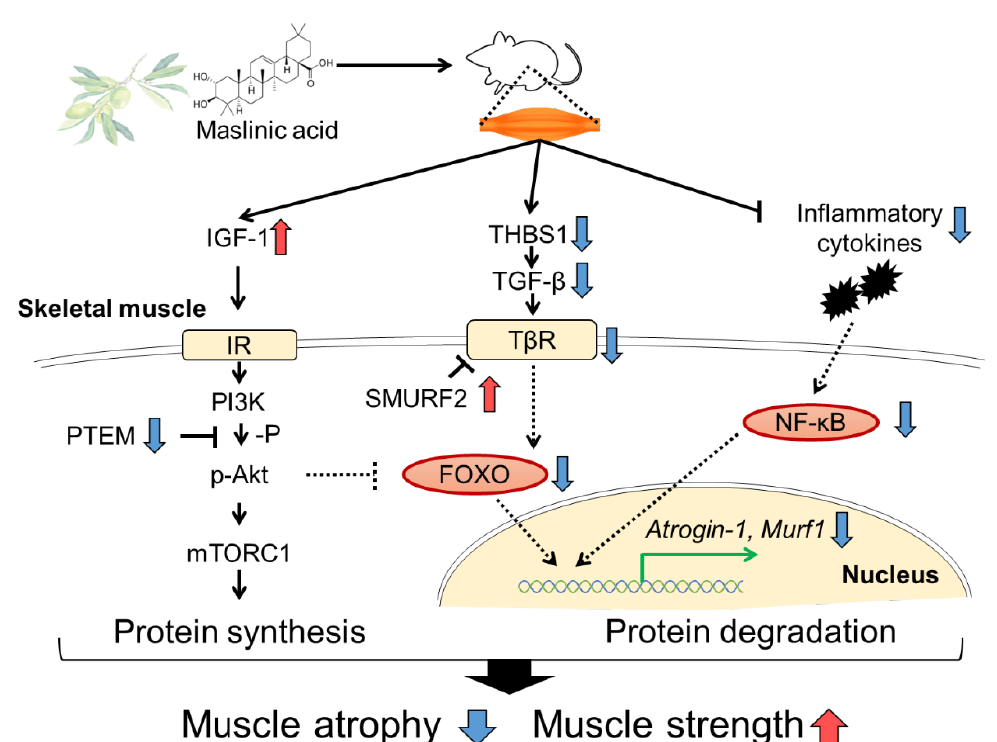
Figure 4. Schematic diagram of the role of preventing muscle atrophy. Dietary MA induces IGF-1, which can regulate the dynamic balance of muscle protein degradation and synthesis. IGF-1 stimulation leads to increased protein synthesis via PI3/AKT/mTOR signaling. In addition, MA acts on anti-inflammation, inhibition of the TGF- β expression, resulting in the regulation of protein degradation, and alleviates muscle atrophy and muscle strength. Abbreviations: IGF-1, insulin-like growth factor 1; IR, insulin-like growth factor receptor; PI3K, phosphatidylinositol 3-kinase; Akt, protein kinase B; PTEM, phosphatase and tensin homolog; mTORC1, mammalian target of rapamycin complex 1; THBS1, thrombospondin 1; LTBP2, latent transforming growth factor- β binding protein 2; TGF- β , transforming growth factor β ; T β R, TGF- β receptor type; SMURF2, SMAD-specific E3 ubiquitin protein ligase 2; FoxO, forkhead box O transcription factors; Murf1, muscle ring finger 1; NF- κB, nuclear factor -kappa B.